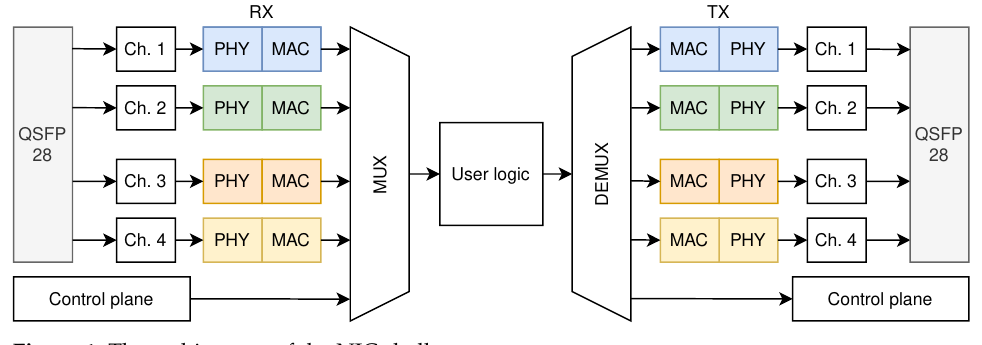
Figure 1. The architecture of the NIC